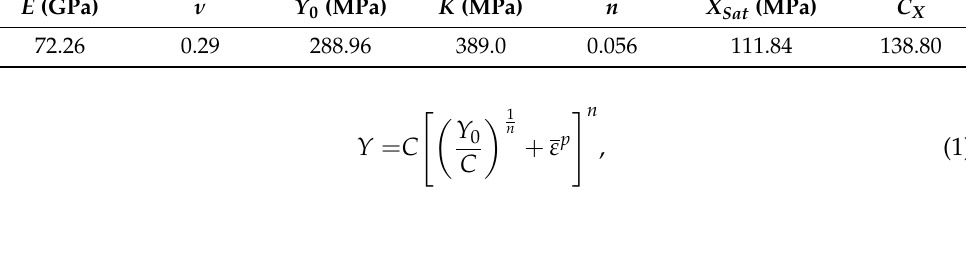
Table 1. Elastic properties and material parameters for the 2024-T351 aluminum alloy. Adapted from [22]. E